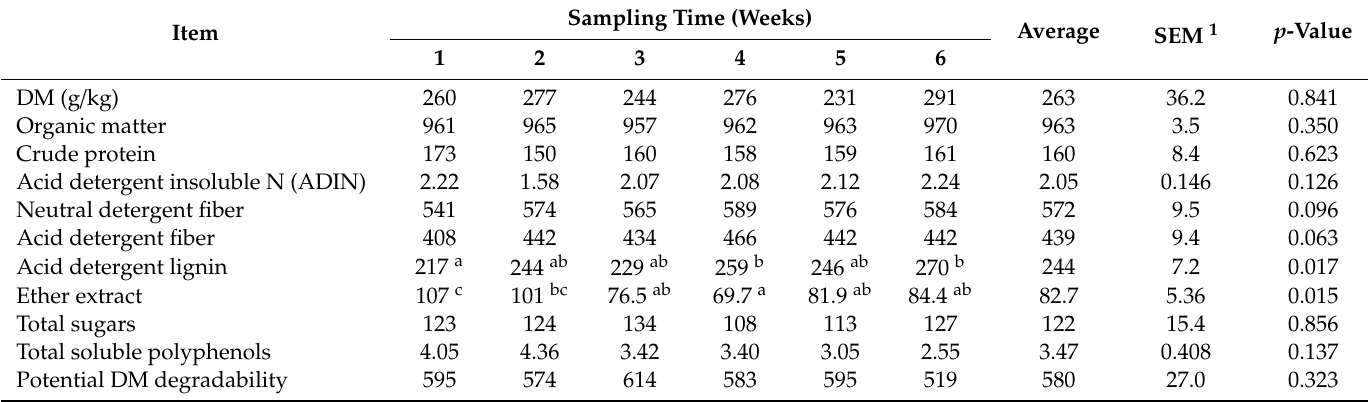
Table 2. Chemical composition (g / kg dry matter (DM) unless stated otherwise) of tomato pomace samples taken from two processing plants at weekly intervals during the tomato harvesting